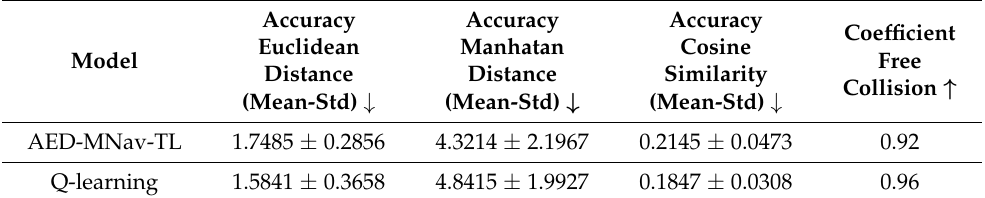
Table 4. Comparative of performance about transfer learning approach and its standard deviation in 50 samples and Q-learning algorithm. Where ↓ Low is better, and ↑ Up is better. AED-MNav-TL (auto-encoder with 3D mesh navigation—transfer learning).